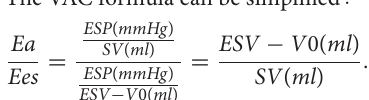
independent predictor. Figure 2 shows greater values and a wide variation of the VACC for patients with normal VAC, while in patients with abnormal VAC elevation, the VACC has lesser values and limited